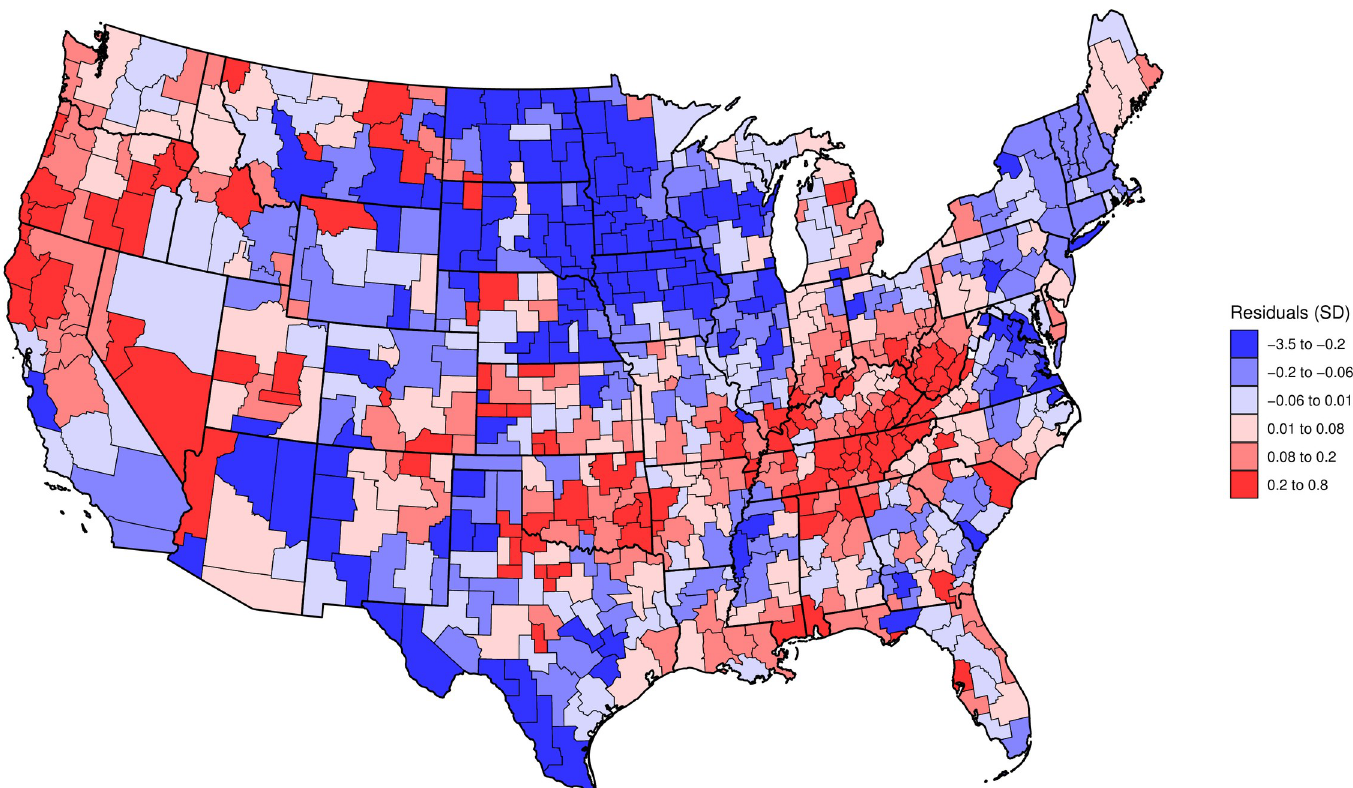
Fig 2. Map of residuals from the regression log(pills) on log(population). Footnote: Commuting Zones were defined using 2010 boundaries. Source: ARCOS and Census Bureau.